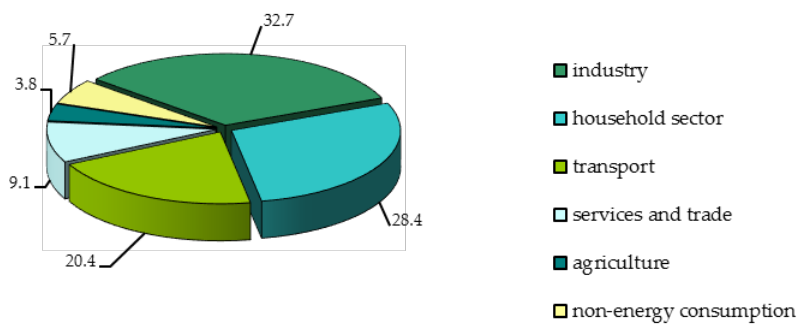
Figure 1. Thestructureoffinal energyconsumption in2019in Ukraine, % Figure 1. The structure of final energy consumption in 2019 in Ukraine, % of total energy con- sumption [24].